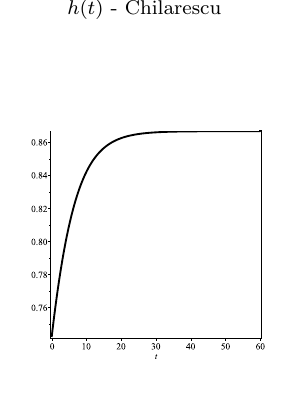
Figure 2. Transitional dynamics for h ( t ) - Naz et al.